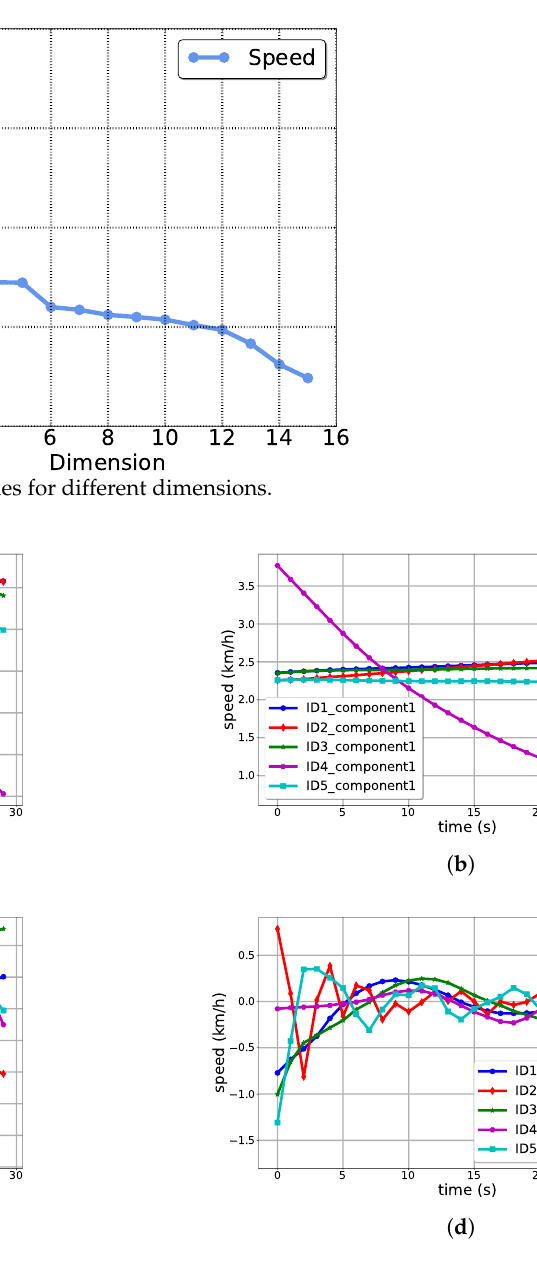
Figure 5. Components of testing vehicle trajectories. ( a ) Original speed data sequence; ( b ) The first component; ( c ) The second component; ( d ) The third